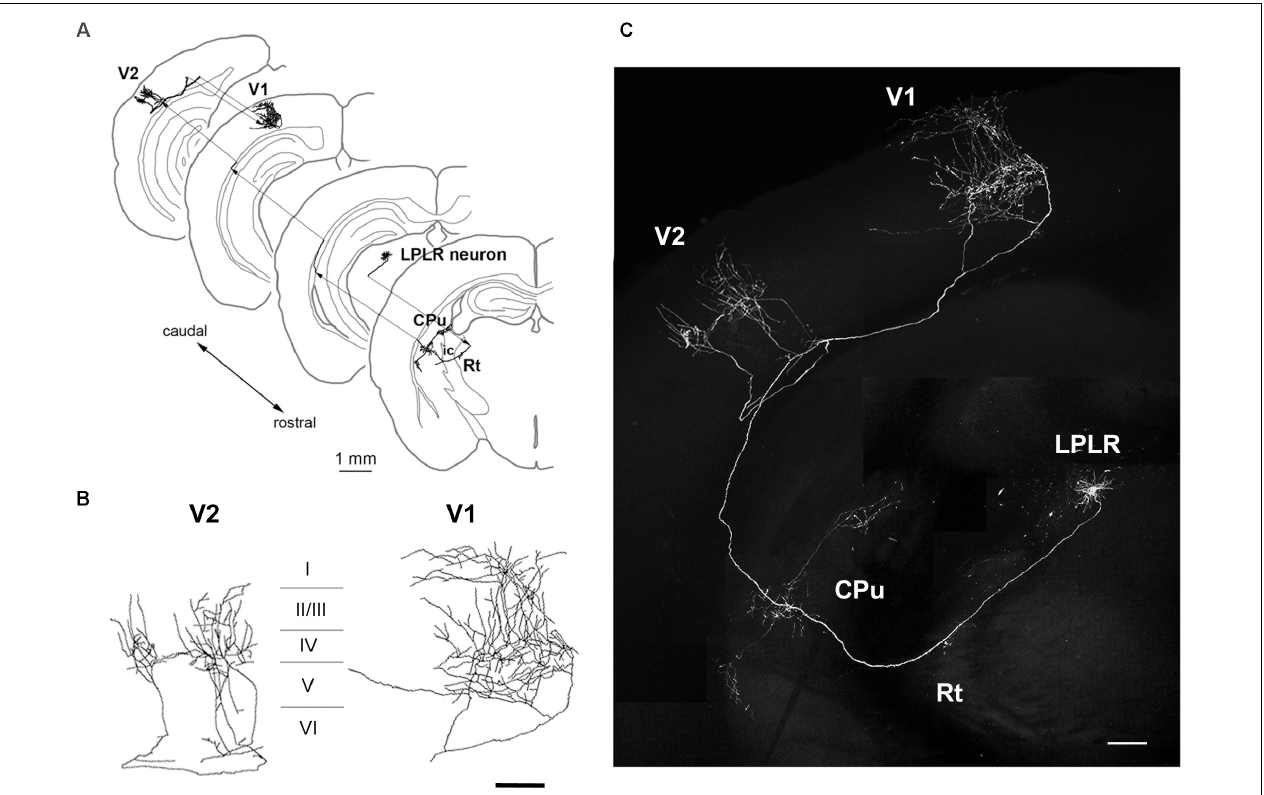
FIGURE 5 | Axonal projection of an LP neuron. (A–C) Main targets of an LP neuron, including V1 and V2 as well as extravisual areas such as the caudate putamen (CPu). The LP neuron located in the laterorostral region of the LP (LPLR) had dense axonal arbor in layers I and V of V1 and layer IV of V2 (B) . Scale bars, 1 mm for panel (A) ; 200 µ m for panels (B,C)